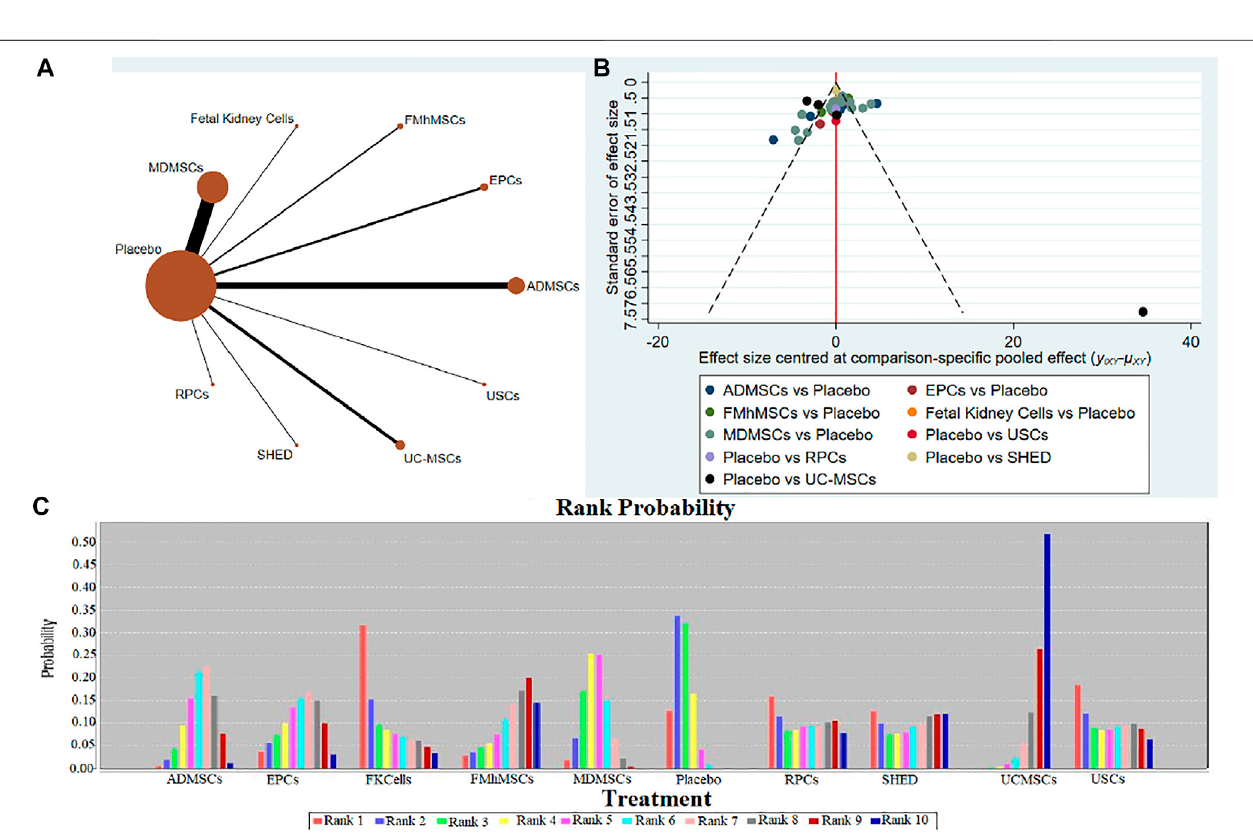
FIGURE 6 | Network Meta-analysis of blood urea nitrogen level at 1 day after administration (A) Evidence network diagram; (B) The comparison-correction funnel plot; (C) The ranking results).